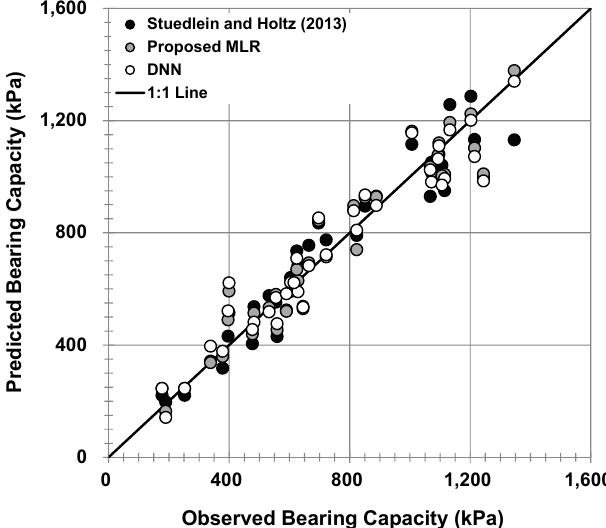
Figure 13. Comparison of the observed ultimate bearing capacity to that of the predicted using three models. Table 6. Performance of prediction methods for ultimate bearing capacity.